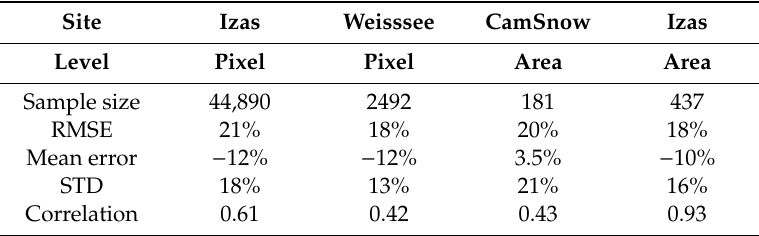
Table 6. Evaluation of the Sentinel-2 FSC with Izas and Weisssee FSC (20 m pixel-based comparison), and CamSnow and Izas mean FSC (in percentage of the imaged area).